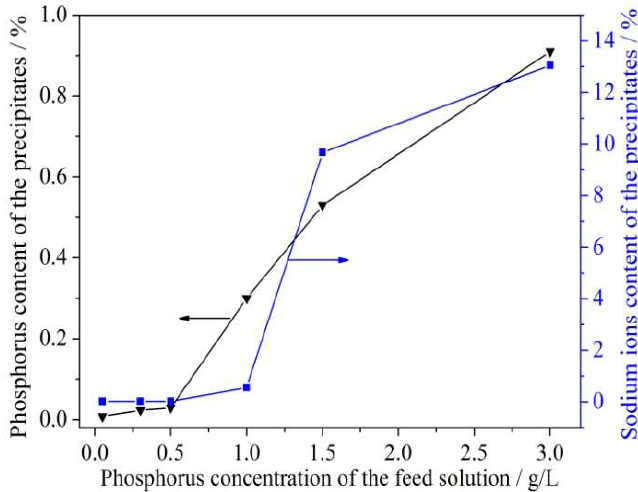
Figure 6. The effects of phosphorus concentration of the feed solution on the phosphorus and sodium ions content of the precipitates.